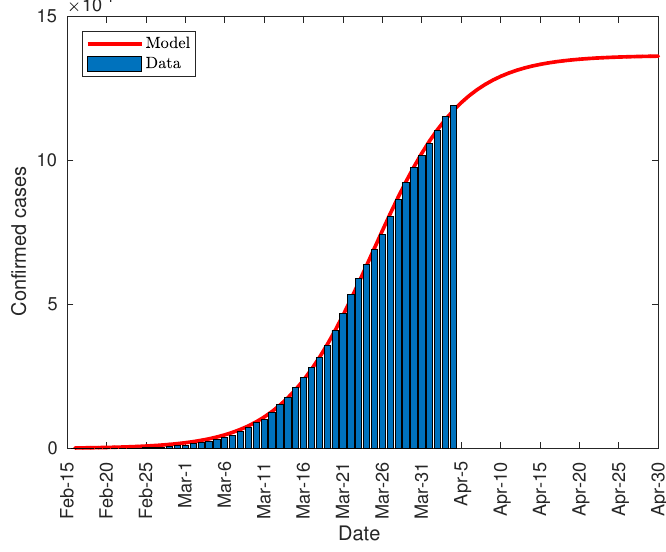
Figure 8. Total number of COVID-19 infections in Italy.